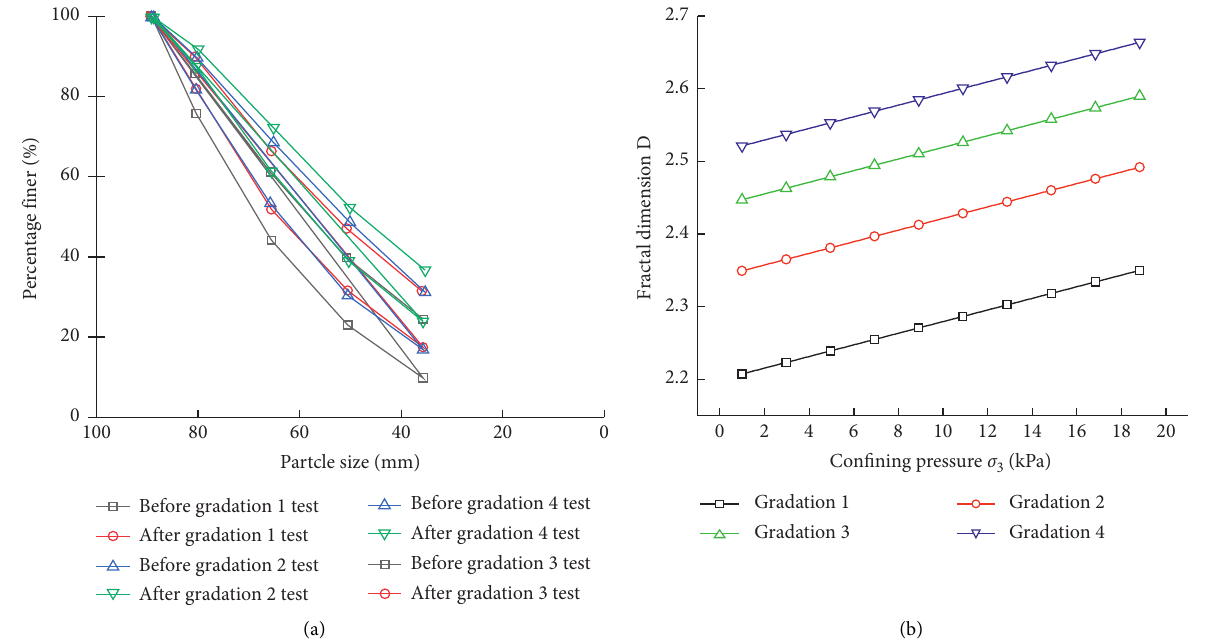
Figure 2: Relationship between the gradation and the fractal dimension. (a) The ratio of the particle size and the mass percentage content. / P a . (b) The curve of the fractal dimension with σ 3